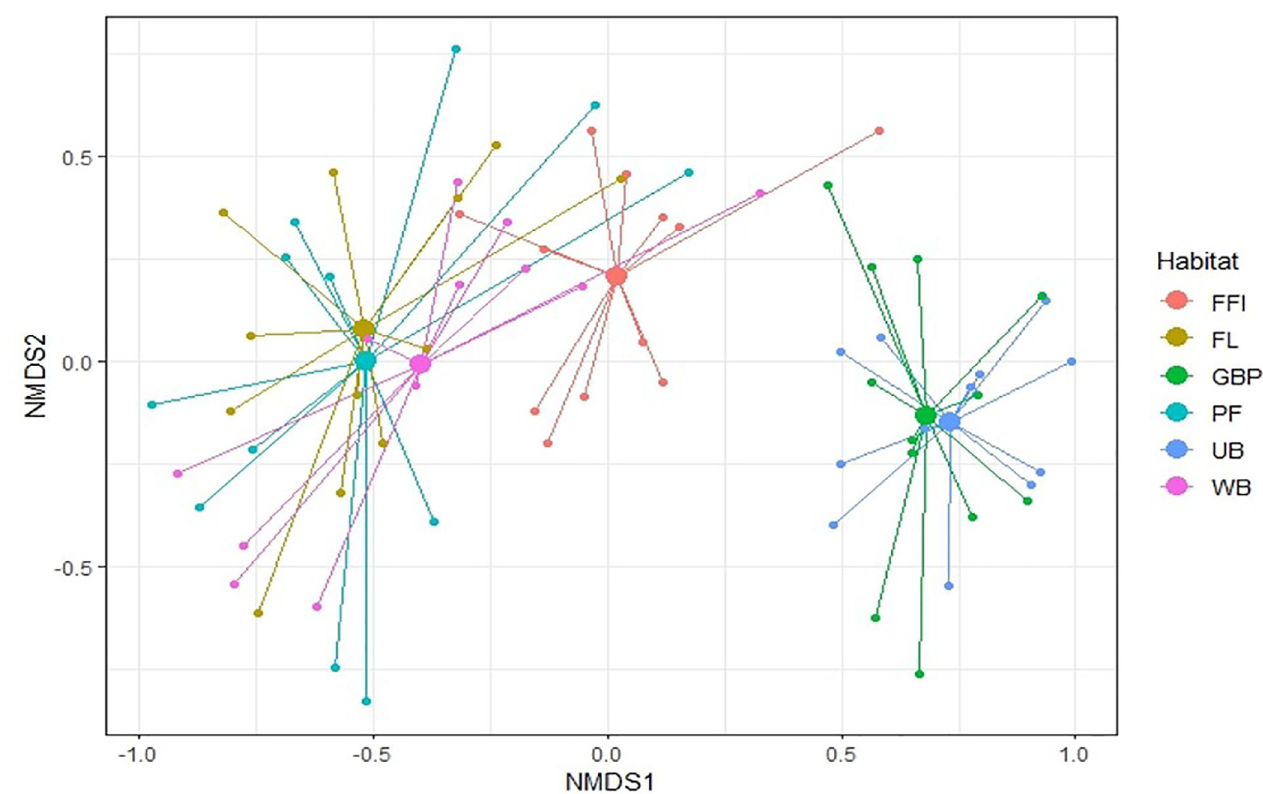
Fig 5. Bird species composition and community patterns among landscape-scale habitat factors. Non-metric multidimensional scaling (NMDS) plot depicting raptor community assemblages in six contrasting habitat types using Bray-Curtis similarity. Pair wise ANOSIM tests revealed significant variation (p < 0.05) in raptor compositions. The vectors that stretch up to the point denote species, whereas the six big dots indicate habitat